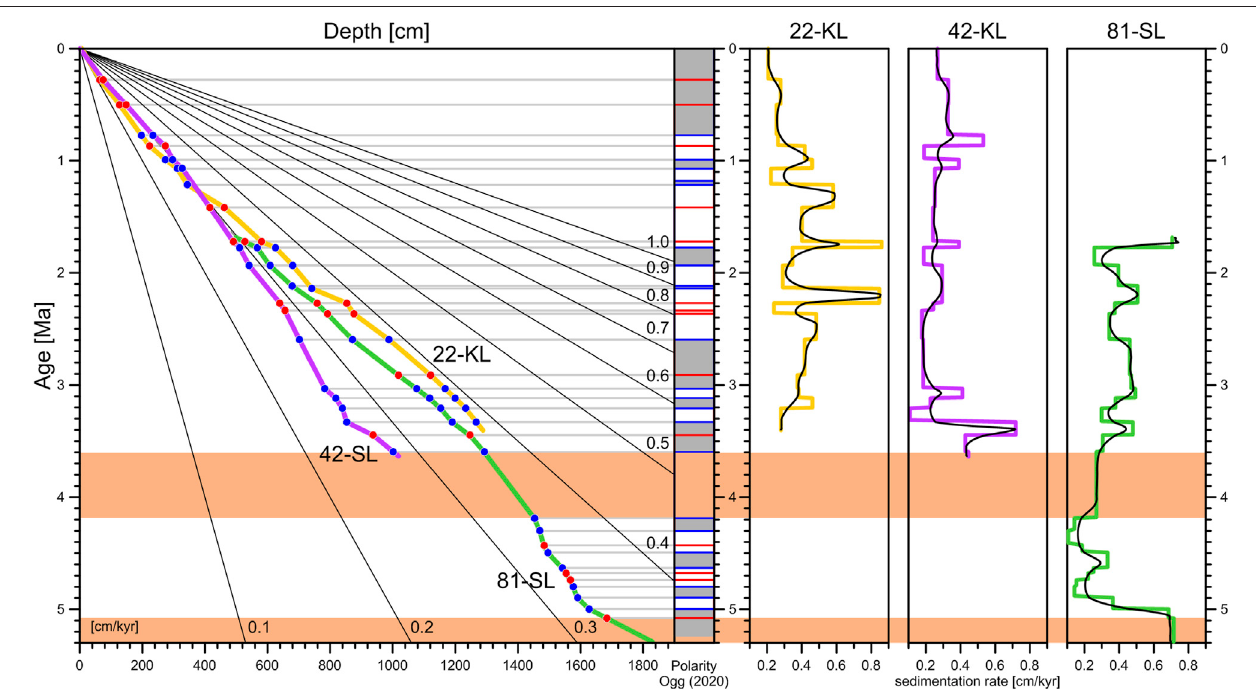
FIGURE 7 | Age-depth models (left) and inferred sedimentation rates (three plots at right) of the three studied sediment cores. The polarity plot in the center (grey standsfornormalpolarity)illustratesthepositionsofageanchorpointsinblue(reversals)andred(RPI).Noreliablepatterncorrelationexistsfortheageintervalsmarkedin orange. The straight radial lines in the age depth plot serve as linear sedimentation rate [cm/kyr] references. The high spatial and temporal variability of sedimentation rates at the different coring sites may result from past sediment dynamics as well as dating uncertainties. Running means in black (500 kyr average) illustrate continuous and probably more realistic sedimentation rate variations, albeit just by plausibility and not by evidence!